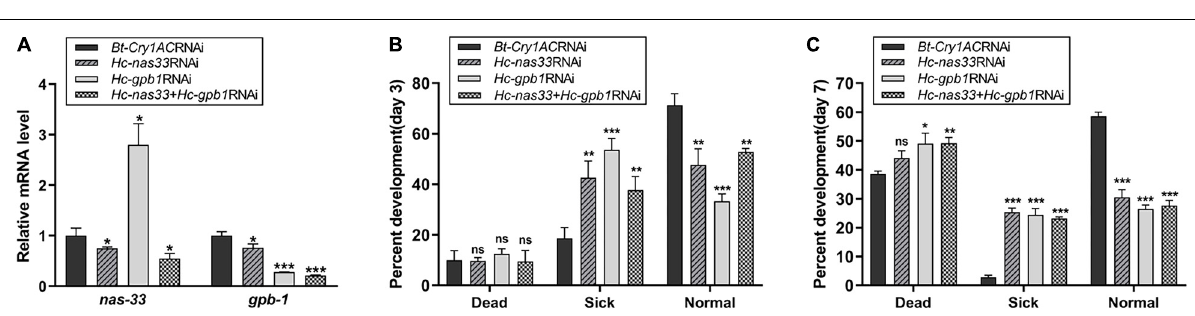
FIGURE 7 | Effects of nas-33 and gpb-1 RNA interference on the development and survival of Haemonchus contortus . (A) Influences of nas-33 or gpb-1 RNAi on the relative mRNA levels (normalized by the transcriptional level of Bt-Cry1AC ) of nas-33 and gpb-1 , respectively. (B) Influences of separate ( Hc-nas-33 or Hc-gpb-1 ) and simultaneous ( Hc-nas-33 + Hc-gpb-1 ) RNAi on the development and survival of H. contortus on day 3. (C) Influences of separate ( Hc-nas-33 or Hc-gpb-1 ) and simultaneous ( Hc-nas-33 + Hc-gpb-1 ) RNAi on the development and survival of H. contortus on day 7. Sick phenotype includes developmental delay, decreased mobility, abnormality and molting defect. Student’s t -test is used for the statistical analysis between treated and negative control. * P < 0.05; ** P < 0.01; *** P < 0.001; ns, no